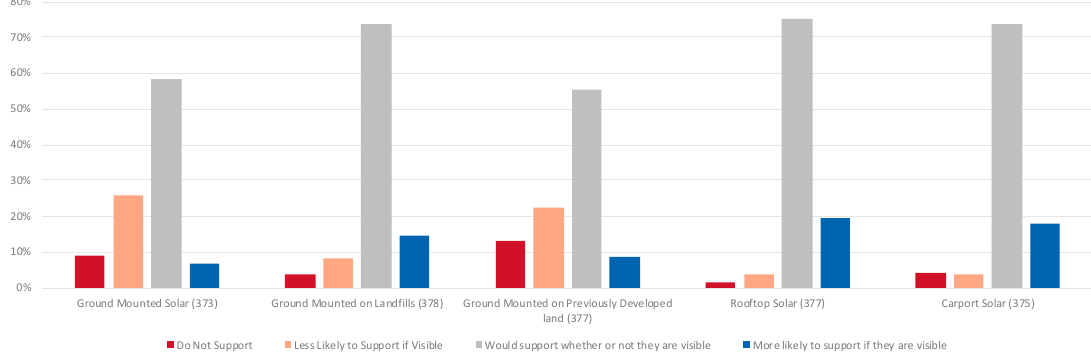
Figure 2. Support by Installation Type. Note: These questions were not required of respondents, thus response numbers ranged from 373 to 378, as indicated on the x axis.